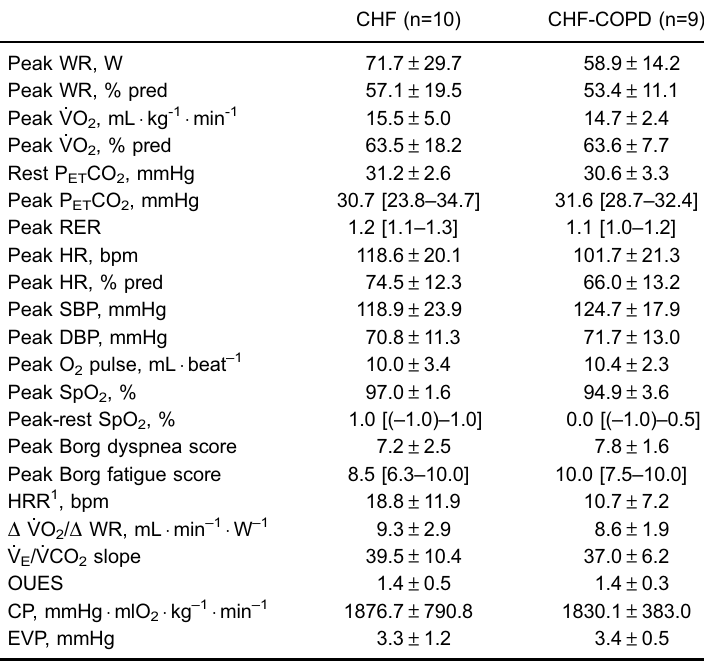
Table 2. Comparison of cardiorespiratory and metabolic responses obtained at peak of cardiopulmonary exercise testing between chronic heart failure (CHF) and CHF-chronic obstructive pulmonary disease (COPD) patients.